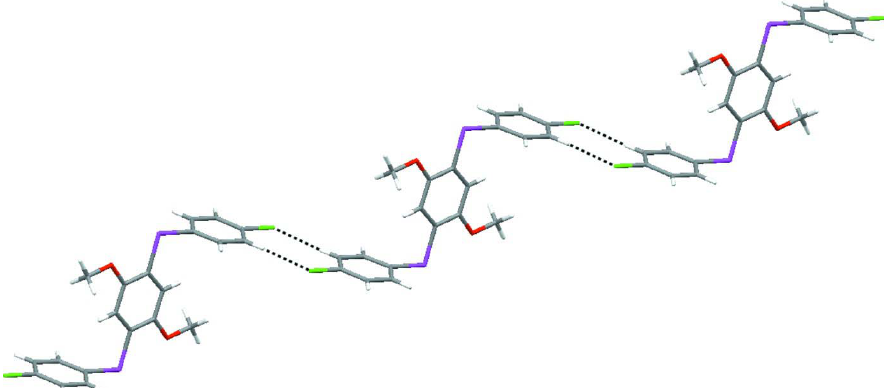
A view of the cyclic C—H···Cl interactions linking the molecules into a